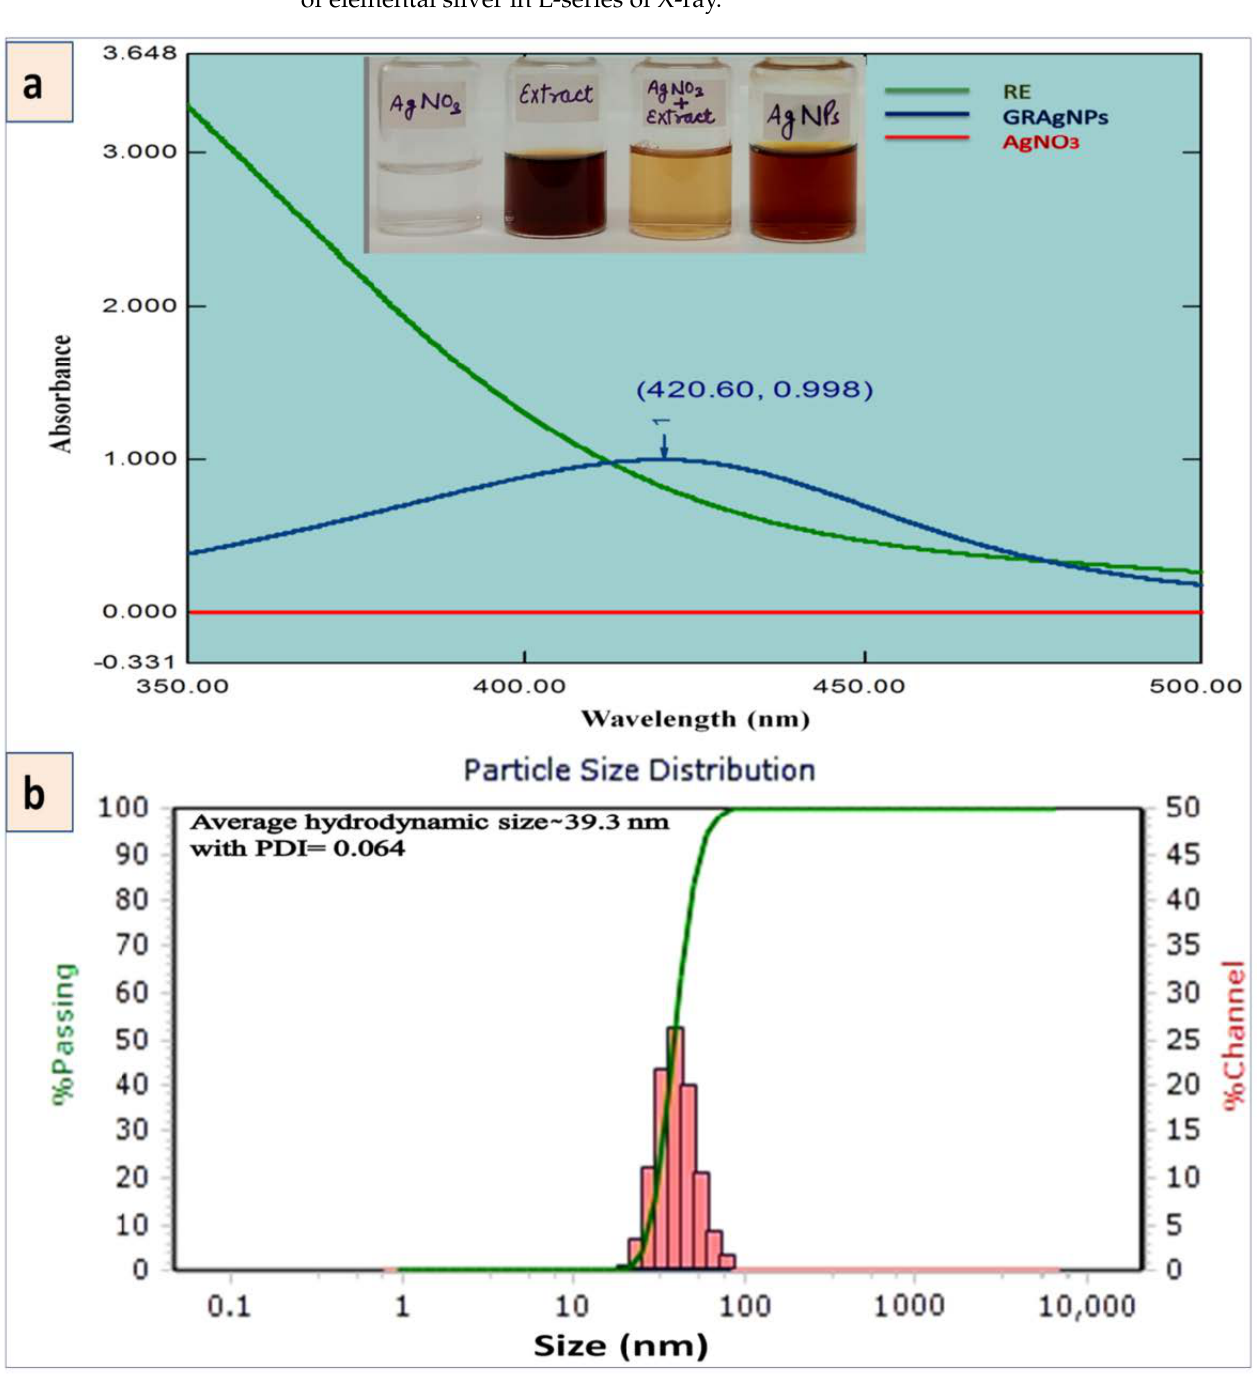
(Figure 2a, panel (ii)). The quantitative results of EDX illustrated a yield of 40.88 weight % of elemental silver in L-series of X-ray.